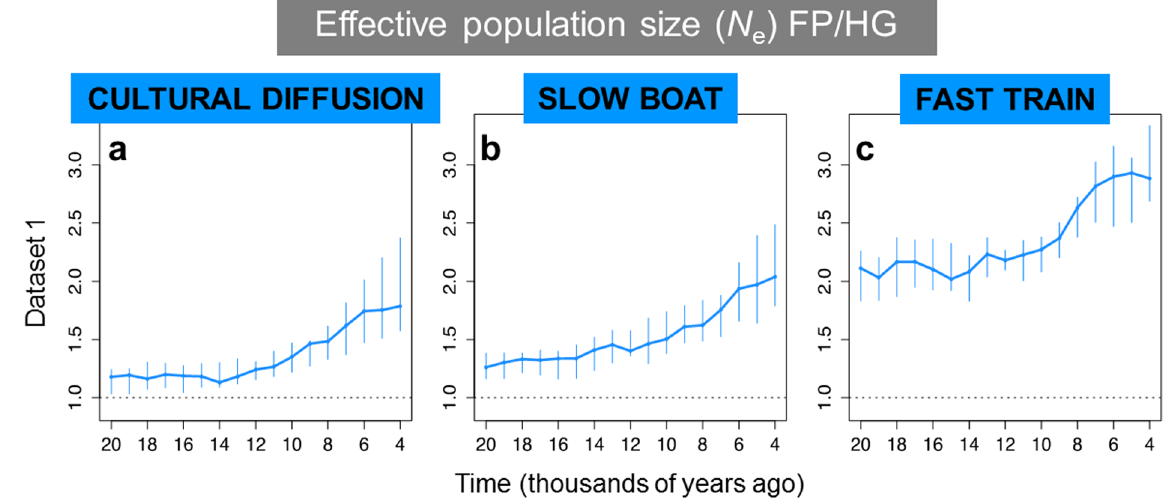
Figure 3. Median of the ratio of food producers over hunter-gatherers for N e /NPP following three different models of Neolithization of SE Asia and Oceania. ( a ) Cultural diffusion; ( b ) “Slow Boat” model (through Indonesia); ( c ) “Fast Train” model (Out of